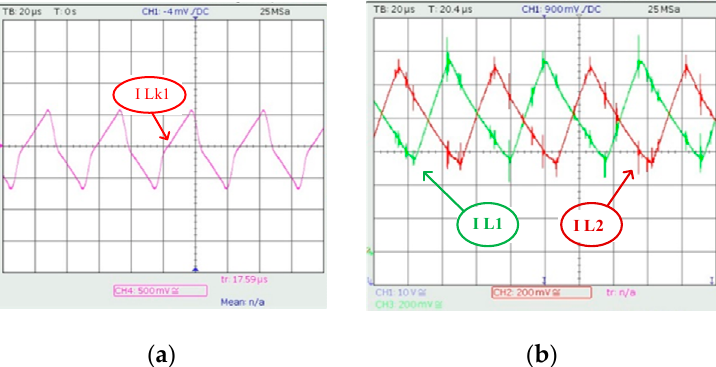
Figure 12. ( a ) Current waveform of the main transformer. ( b ) Current waveform of the input inductors.